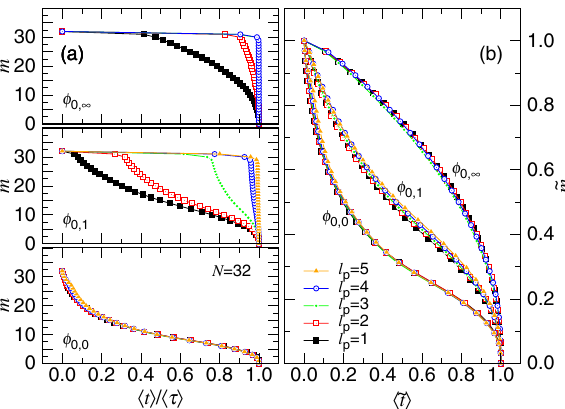
φ 0, , φ 0,1 , and φ 0,0 . ( b ) Time variation of the = ∞ m and t at the three φ 0 . The value of ℓ p can be read �˜ ˜ �